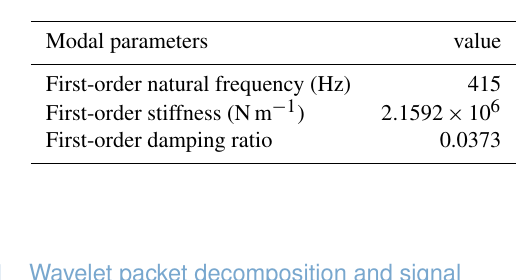
Table 3. Modal parameters of